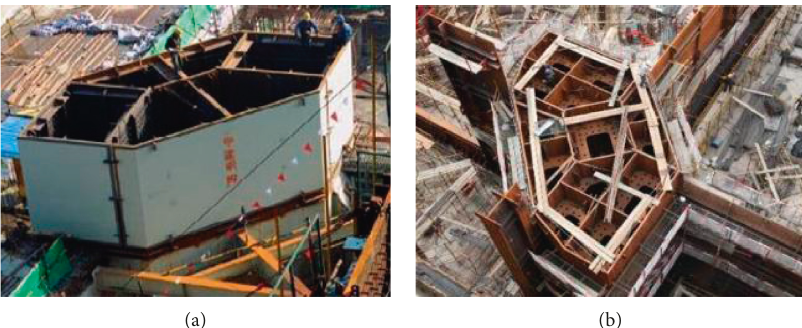
Figure 1: Adhibition of hexagonal CFST columns in practical engineering projects. (a) Gao Yin finance building. (b) CITIC tower.